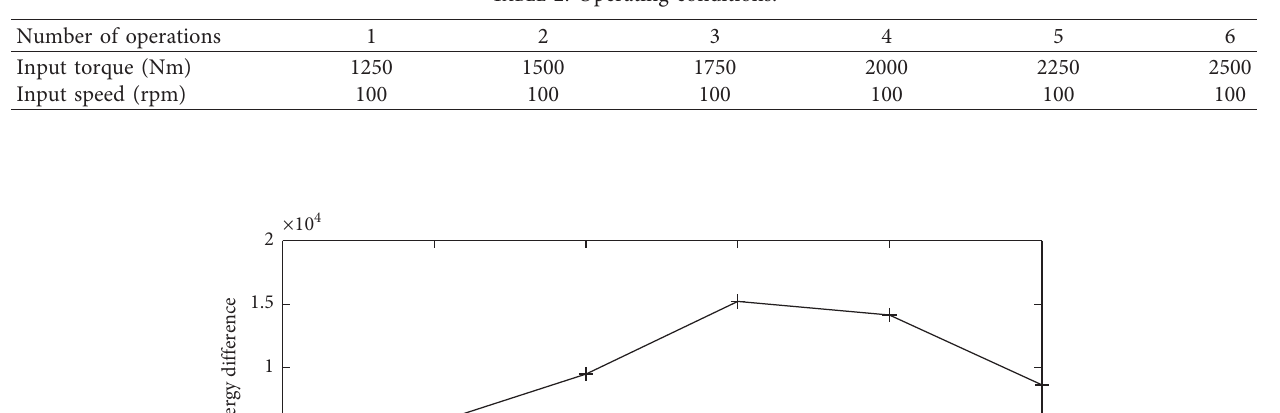
Figure 18: Signal energy of s- p